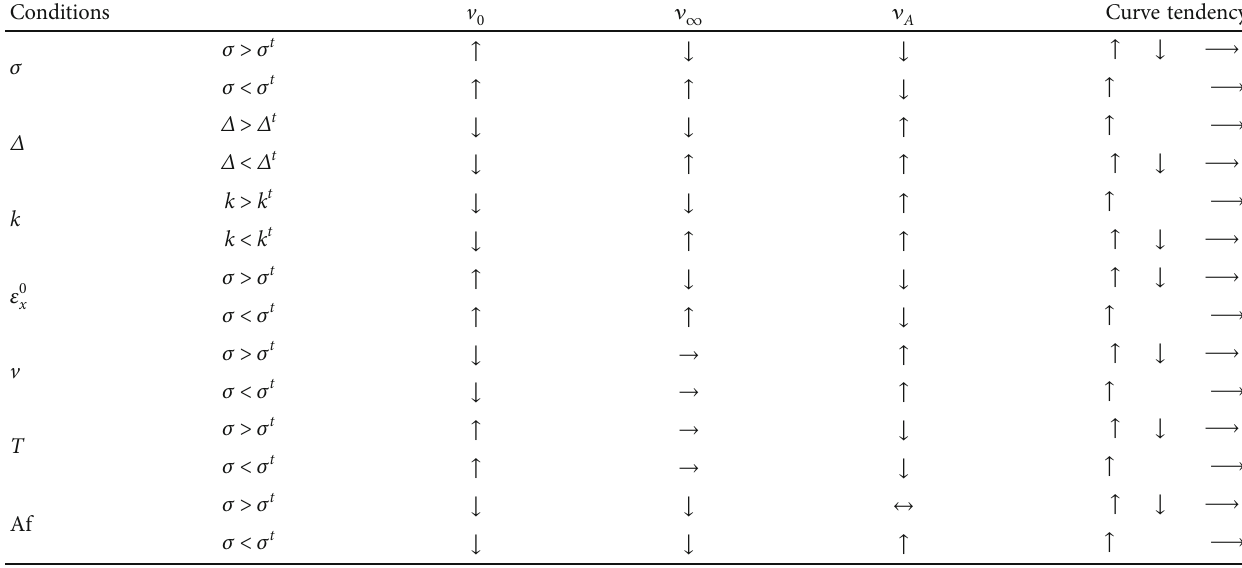
Table 7: Variation tendency of characteristic Poisson ’ s ratio and its curve under di ff erent conditions. Conditions Curve tendency